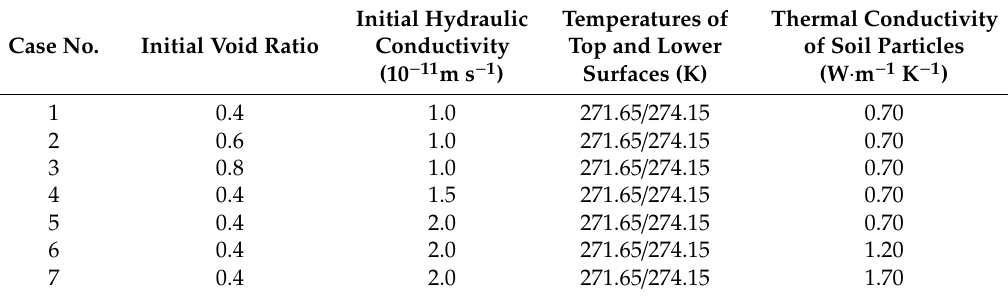
Table 3. Values of the variables in the simulated